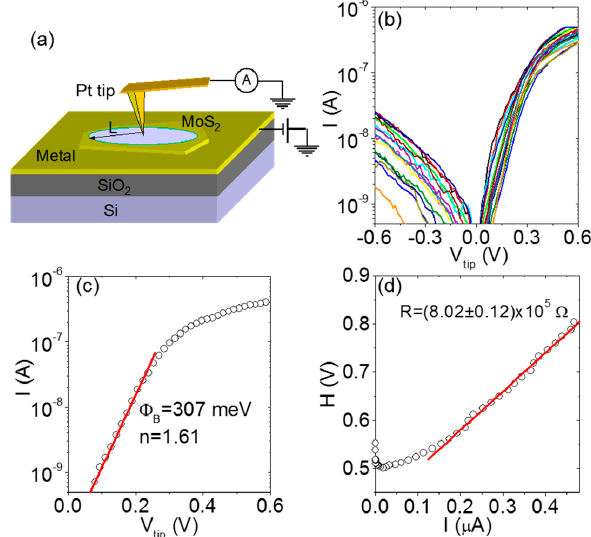
I - V tip characteristics measured on a 500 × 500 nm array of tip positions with ~100 nm spacing on MoS 2 . ( c ) Representative forward bias I - V tip characteristic from this set of measurements and fit with the thermionic emission law to extract the Schottky barrier height (SBH) and ideality factor. ( d ) The H function plot for the determination of the series resistance R . Figures adapted with permission from Reference [44], copyright from the American Physical Society